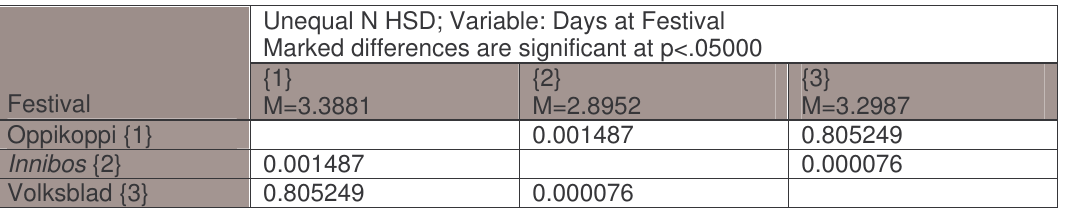
Table 8: Days spend and festivals Unequal N HSD; Variable: Days at Festival Marked differences are significant at